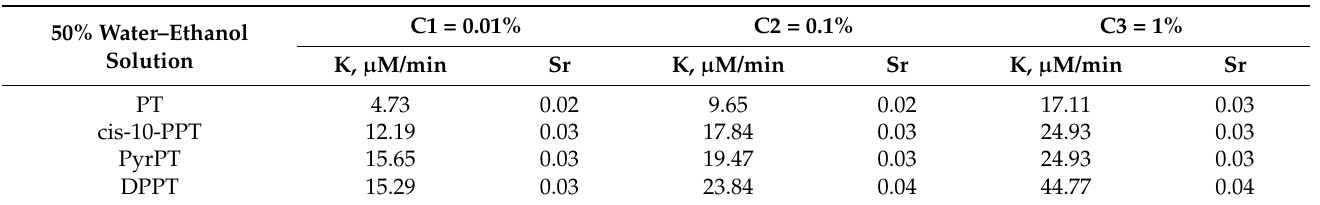
Table 4. Values of the antioxidant activity of phenothiazine and its derivatives in 50% water– ethanol solution.